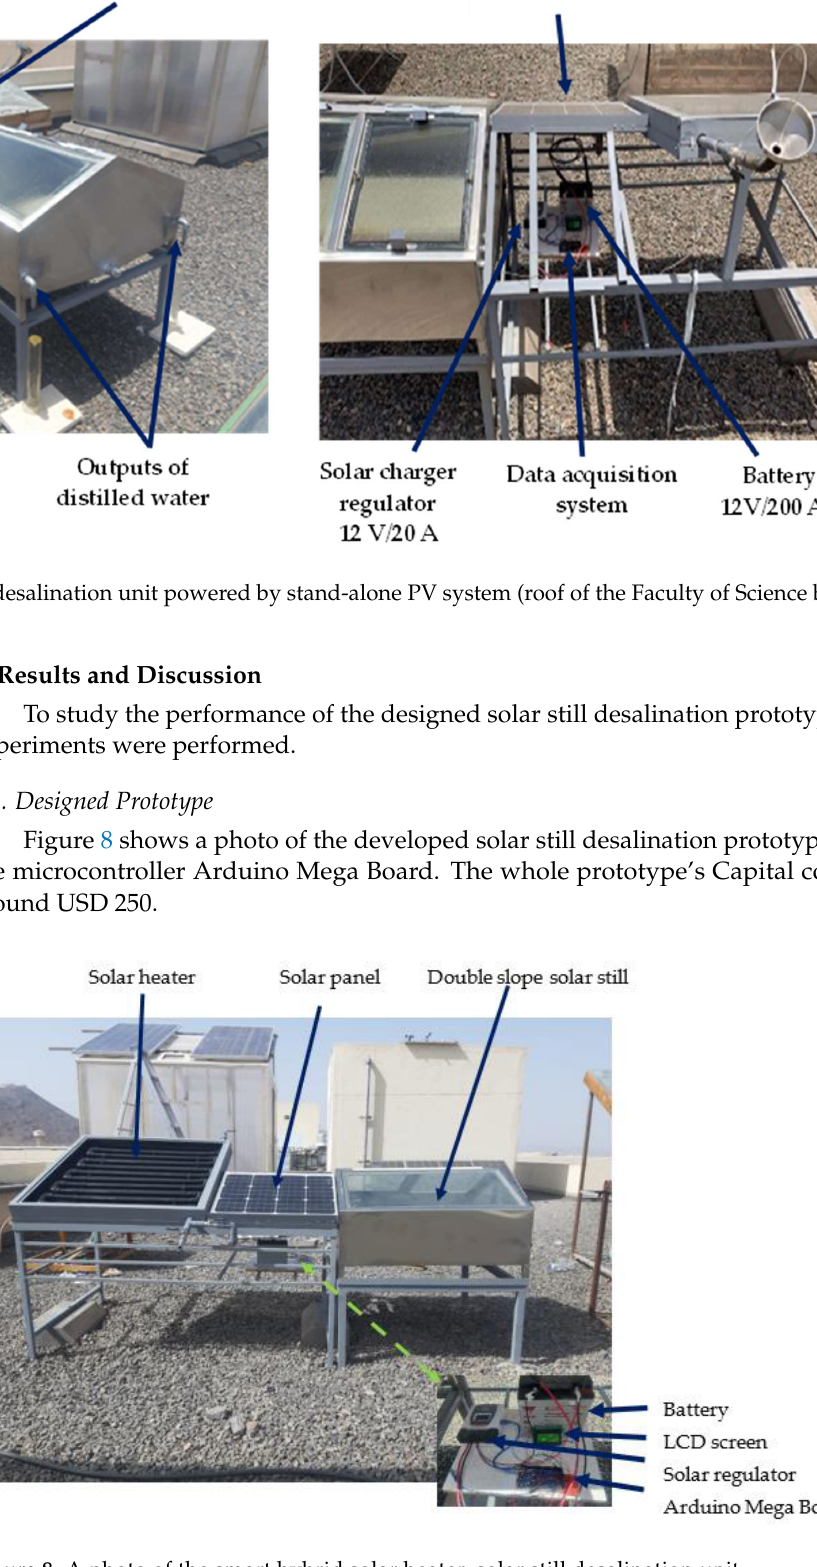
Figure 6. Supplying the SSDU using a PV system.